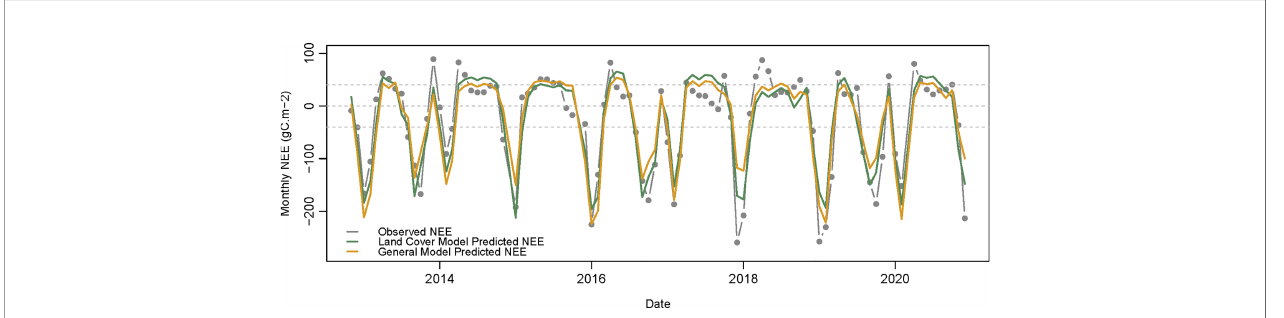
FIGURE 4 | Temporal dynamics of observed (gray line) and predicted NEE with both models. The yellow line represents general model prediction and the green line shows land cover model prediction. Gray dashed lines around zero enclose the area between ±40 gC m − 2 month − 1 where ef fi ciency to determine whether the fi eld behaved as a carbon source or sink drops to 76%.